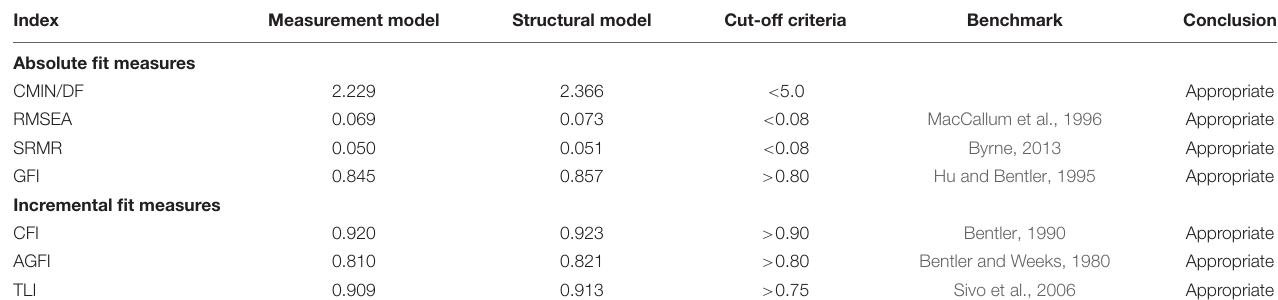
FIGURE 2 | Model fit measures. TABLE 1 | Model fit